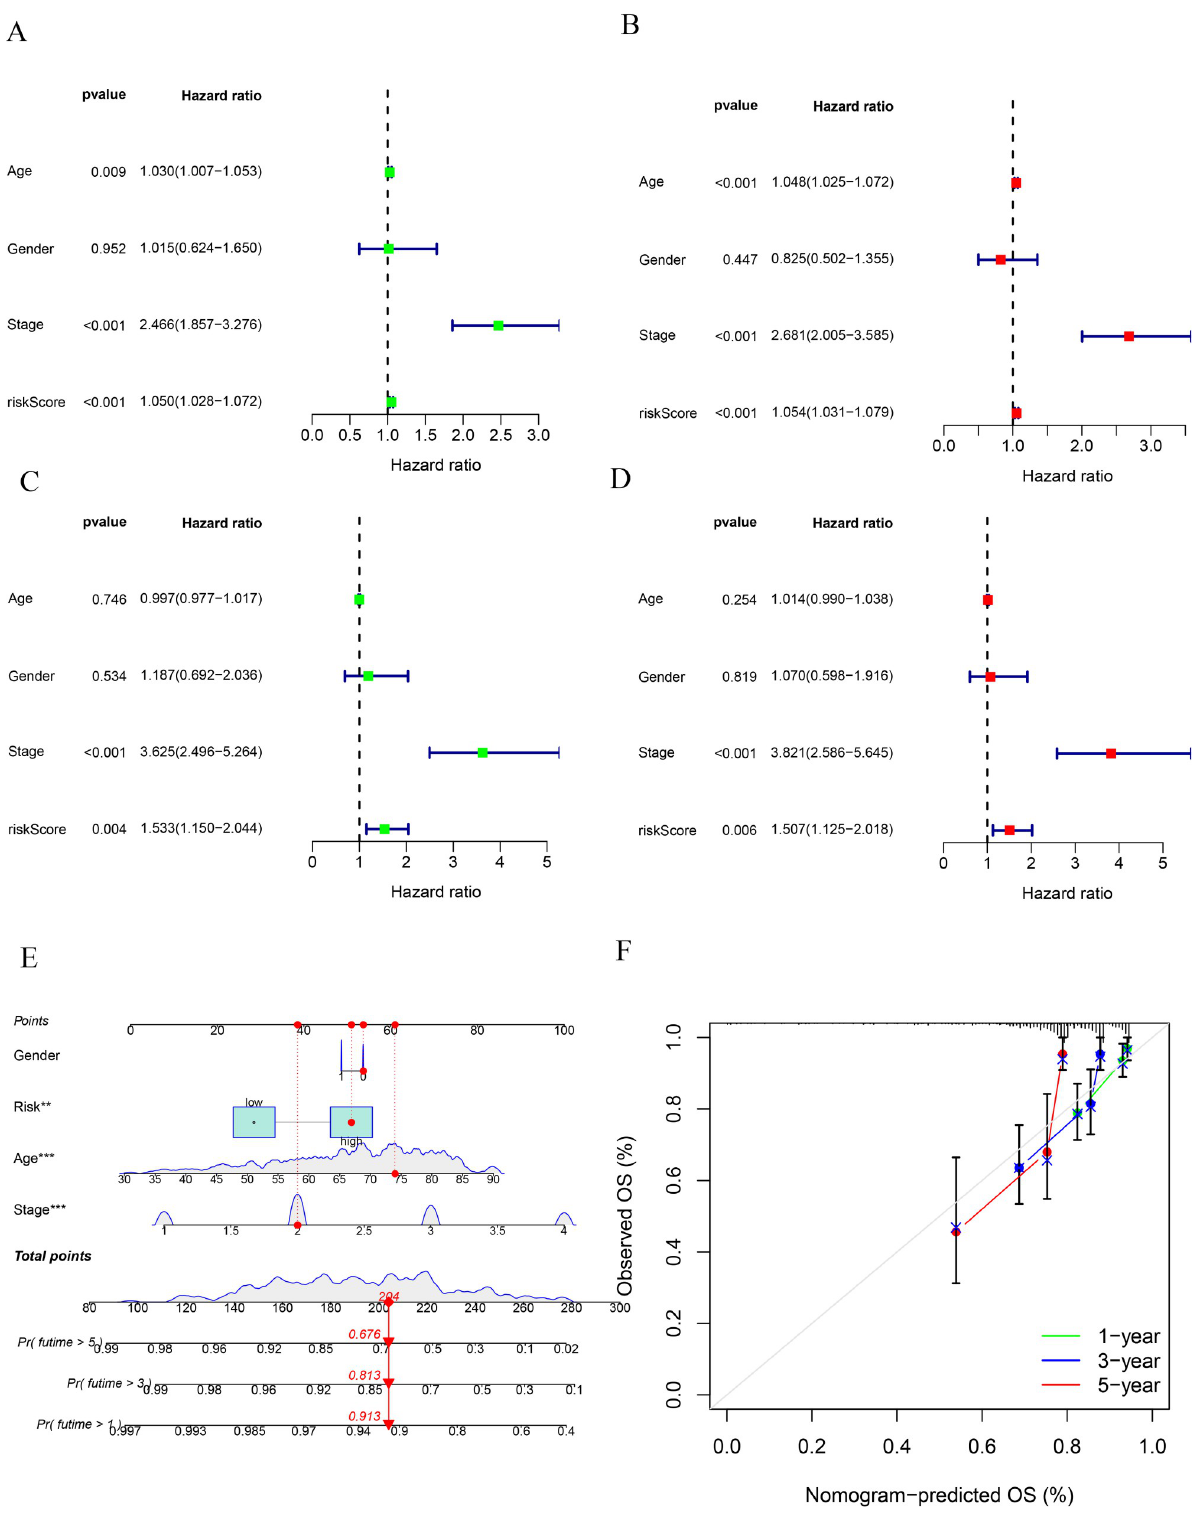
Fig 7. Results of univariate and multivariate Cox analyses. Univariate (A) and multivariate (B) independent prognostic analysis of training group in TCGA. Univariate (C) and multivariate (D) independent prognostic analysis of test group in GEO. Nomogram (E) for prediction of the 1-, 3-, and 5-year OS of patients with COAD in TCGA cohort (each variable is given a score, and an overall score is derived to predict a 1-, 3-, and 5-year